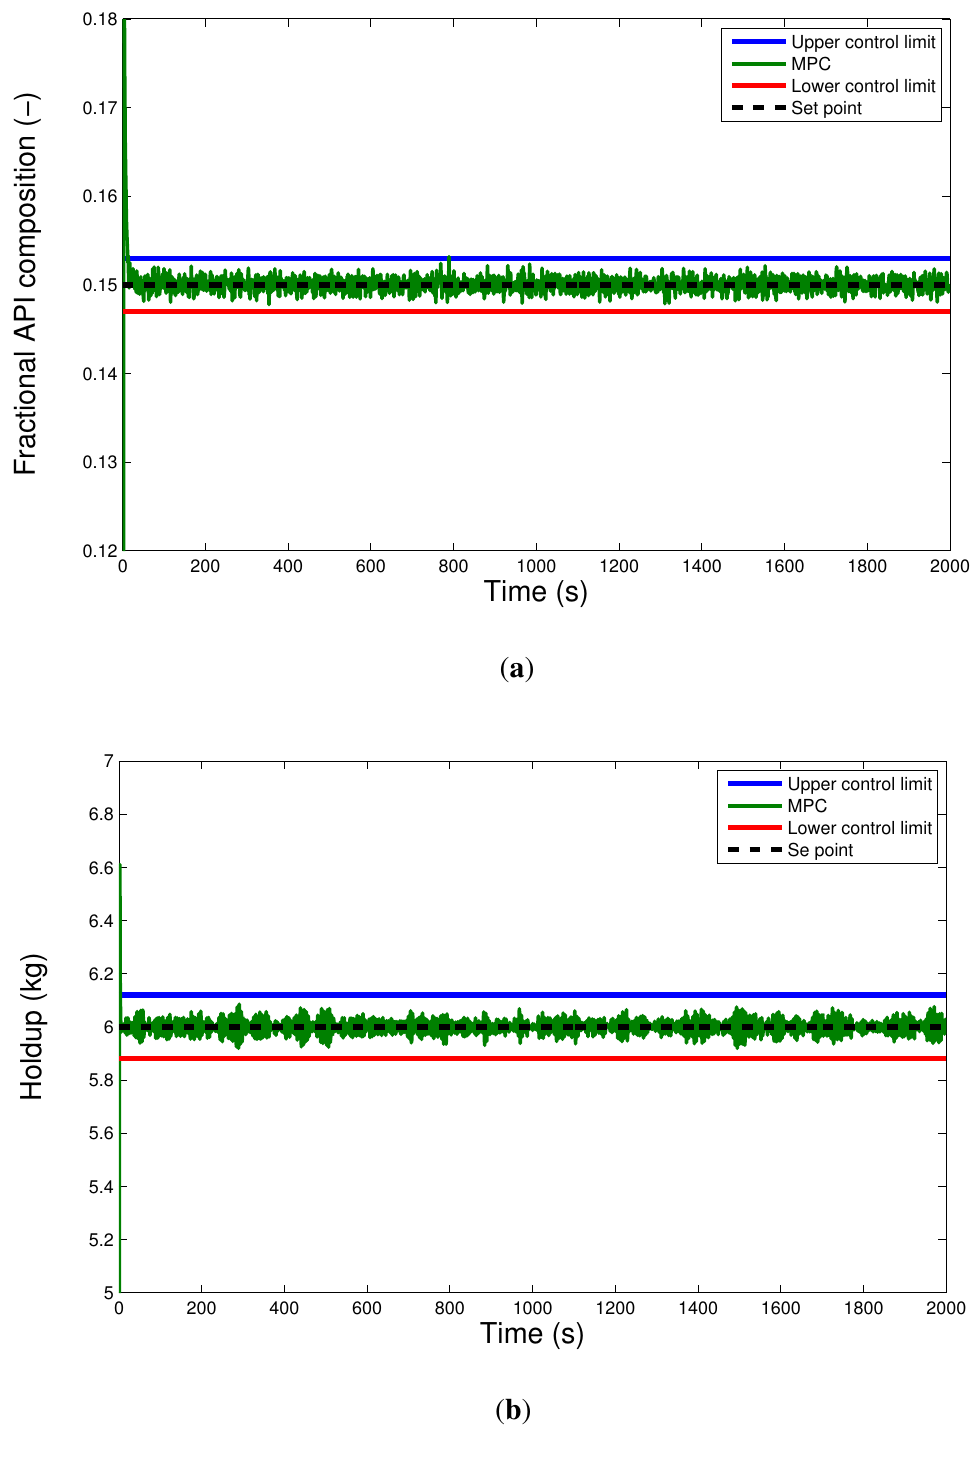
Figure 5. Hybrid MPC-PID performance of the mixing process. ( a ) API composition; ( b )